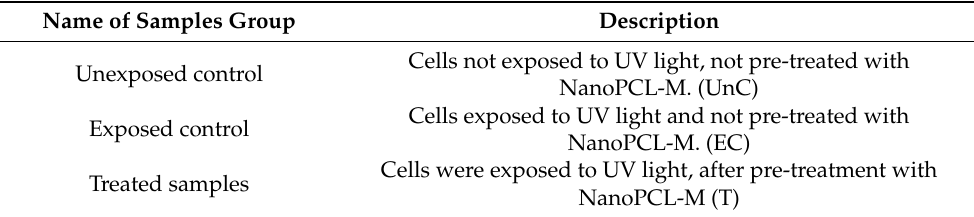
Table 1. The groups analyzed for both HFF1 and SSCs. EC and T cells were exposed to UV light (253.7 nm) for 2 min at 10 cm distance from the lamp to induce oxidative stress. Name of Samples Group Description Cells not exposed to UV light, not pre-treated with Unexposed control NanoPCL-M. (UnC) Cells exposed to UV light and not pre-treated with Exposed control NanoPCL-M. (EC) Cells were exposed to UV light, after pre-treatment with Treated samples NanoPCL-M